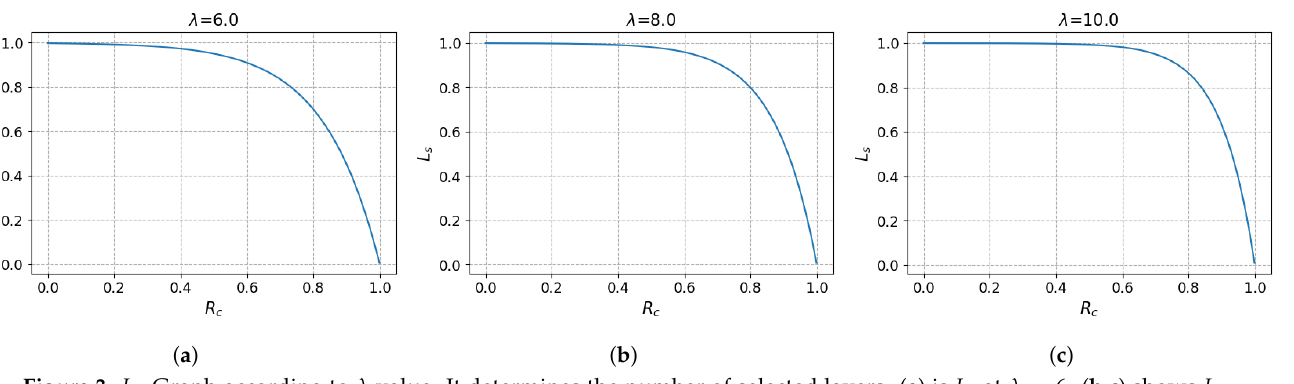
Figure 3. L S Graph according to λ value. It determines the number of selected layers. ( a ) is L s at λ = 6. ( b , c ) shows L s at λ = 8 and λ = 10, respectively. If current compression rate R c is small, L s is close to 1, which means almost all layers are selected. Thus, it can reach the target compression rate quickly. And, when R c is larger, L s drop to zero. It means if compression rate is sufficient to target, layers are selected in more